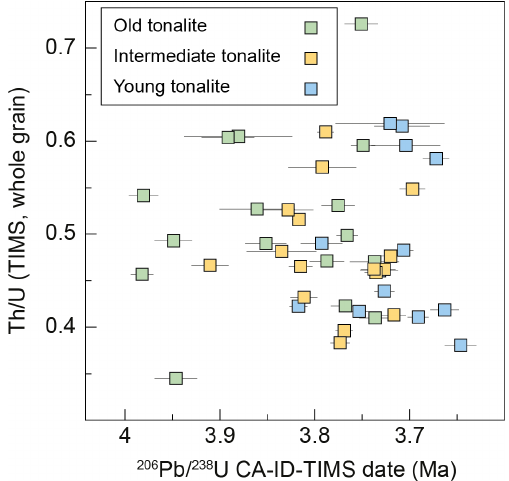
Figure 6. Th / U ratios plotted against time. Both values obtained from CA–ID–TIMS analyses of the same sample